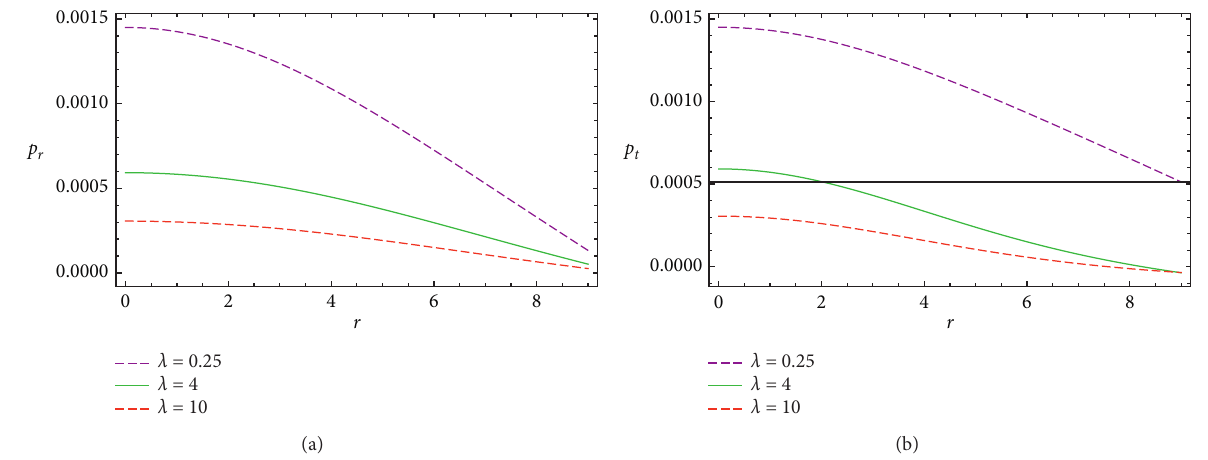
Figure 3: Graphical behavior of p